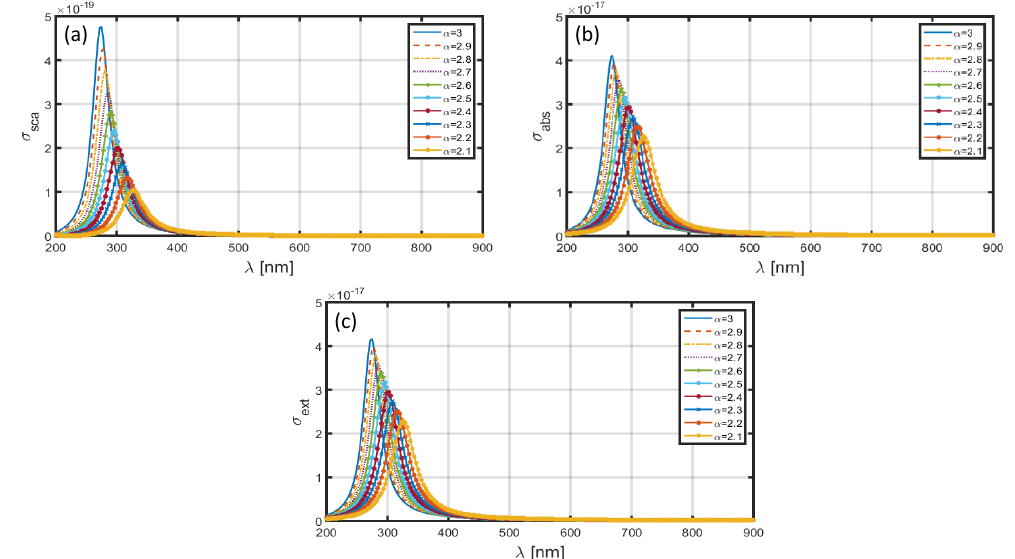
Figure 6. Plots of ( a ) scattering cross-section, ( b ) absorption cross-section, and ( c ) extinction coe ffi cient against λ for SiO 2 -Al nanoparticle in the FD space corresponding to the dimensions a = 1.6 nm, b = 2 nm.